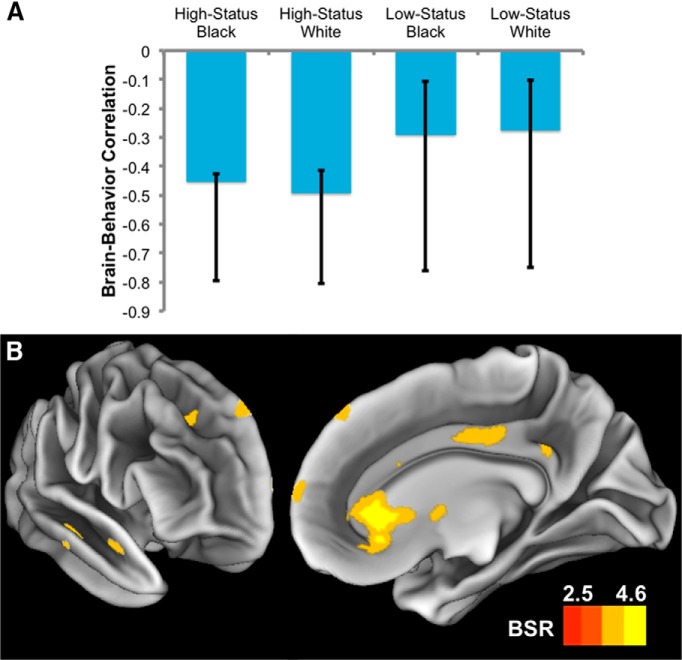
A, External motivation to respond without prejudice (EMS) emerged as a significant LV in behavioral PLS analysis. Brain–behavior correlations were similar across conditions. B, Patterns of whole-brain activity covarying with EMS are presented on lateral–anterior (left) and medial (right) views of the right hemisphere. All voxels with BSR ≥2.5 are displayed, irrespective of their respective cluster sizes. Note that the directionality of brain activity needs to be interpreted in conjunction with the plotted brain–behavior correlations in A. Increasingly positive BSRs in B indicate greater reliability of the negative brain–behavior correlations depicted in A.